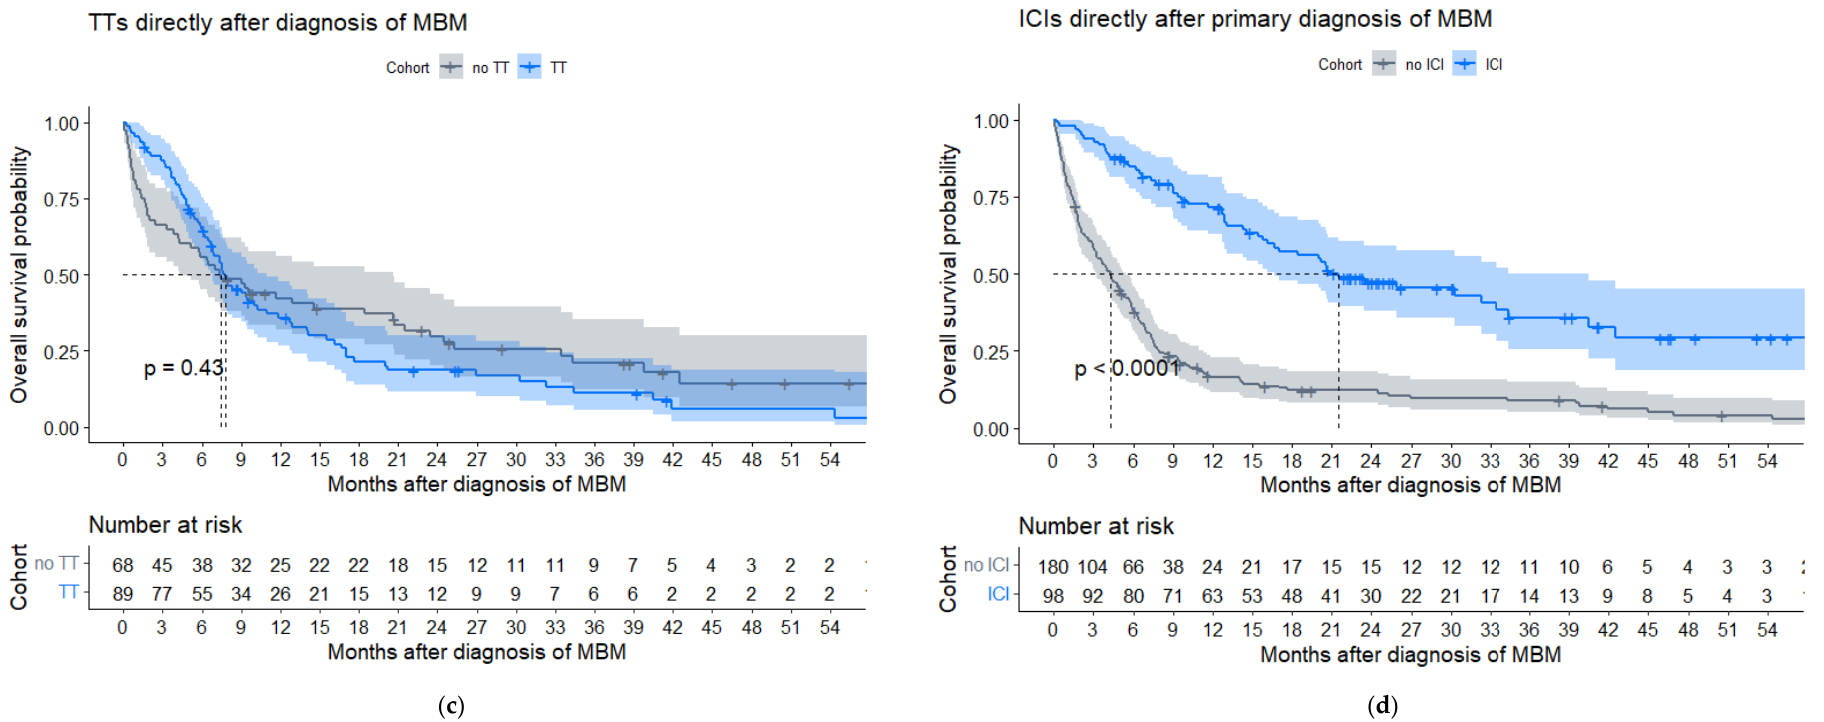
Figure 4. Kaplan – Meier estimates of systemic treatments given to patients with melanoma brain metastasis (MBM) of the post-2015 cohort ( n = 278). ( a ) TTs or no TTs prior to diagnosis of MBM in patients with a targetable BRAF V600E or K+ mutation ( n = 157). ( b ) ICIs or no ICIs prior to diagnosis of MBM. ( c ) TTs or no TTs directly after diagnosis of MBM in patients with a BRAF V600E or K+ mutation ( n = 157). ( d ) ICIs or no ICIs directly after diagnosis of MBM.